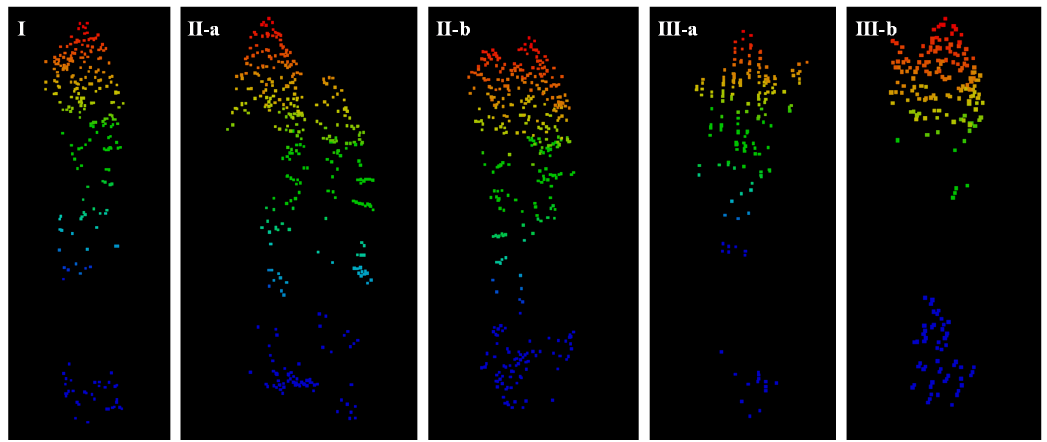
Figure 10. The diagram of region growing algorithm segments.